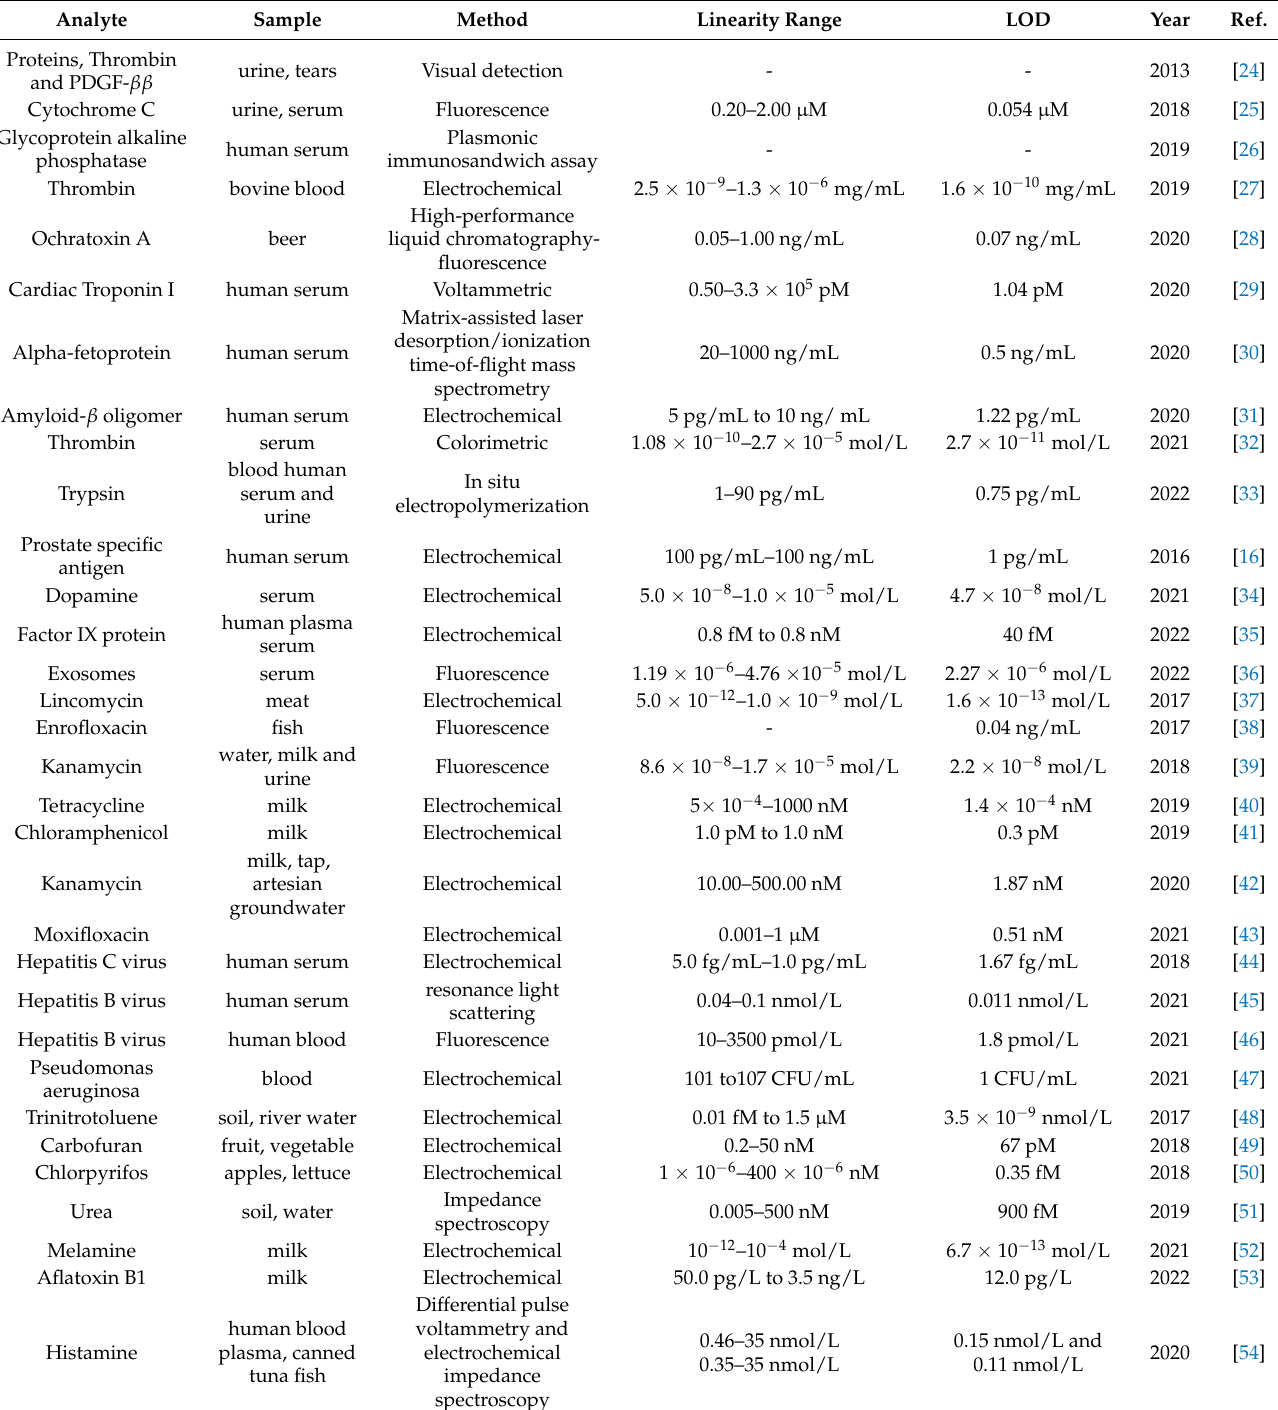
Table 2. Applications of MIP–aptamer during